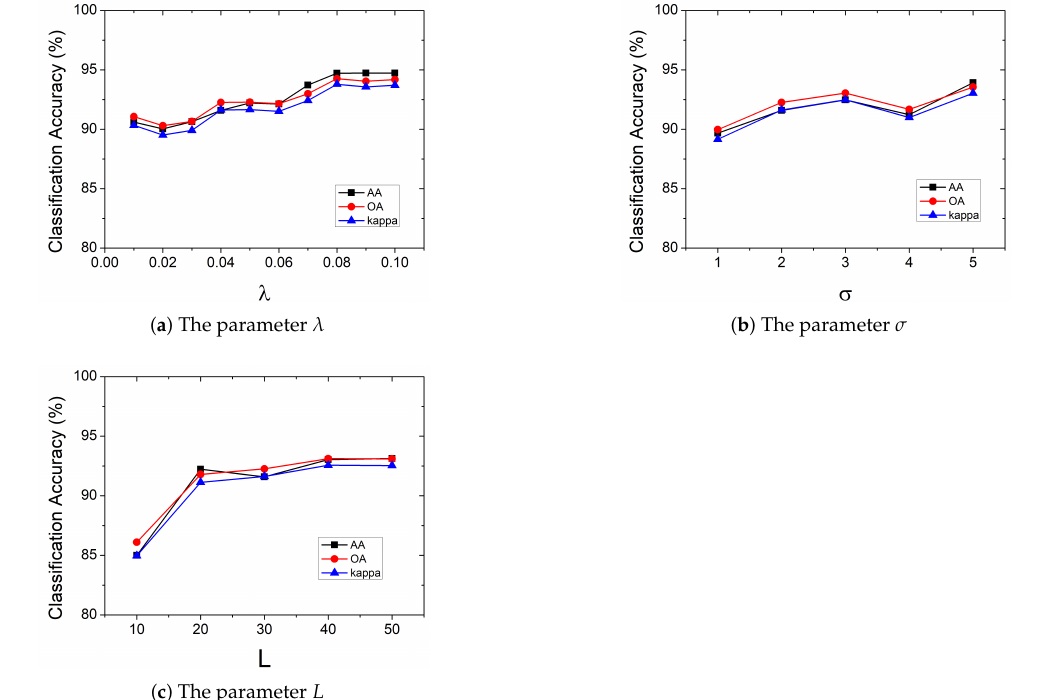
Figure 9. Influence of the parameters on the CNN classification accuracies of the proposed method on the 2012 Houston